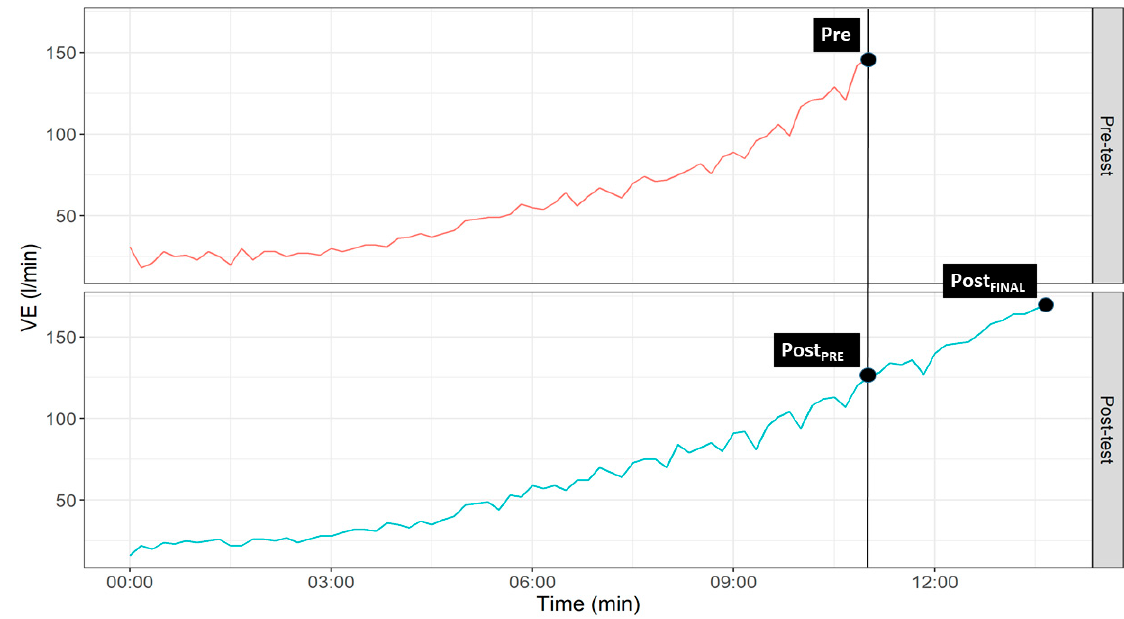
Figure 2. Graphical representation of temporal points selected for statistical analyses.